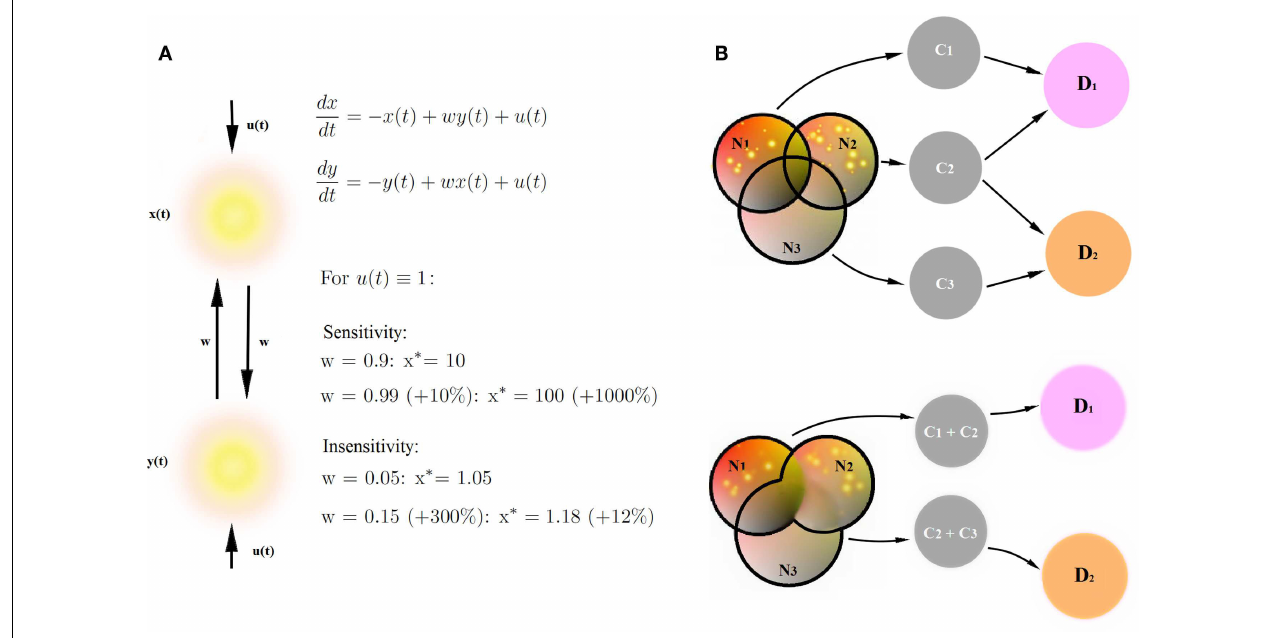
FIGURE 4 | Benefits of CCM . (A) Stable connectivity patterns and connectivity strengths are two sides of the same coin. Let us assume that our sigmoidal transfer function can be approximated as a simple linear function.We provide an example of a network sensitive to changes